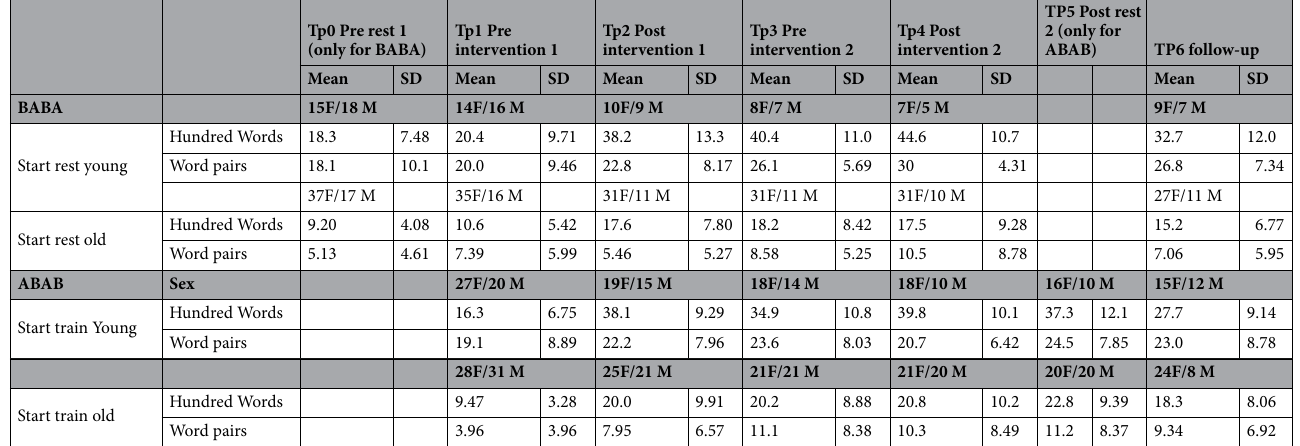
Table 4. Scores on the hundred words task (criterion task) and the word pair task (transfer task) of young and older training groups at all time points, separated by group allocation according to the ABAB/BABA design.